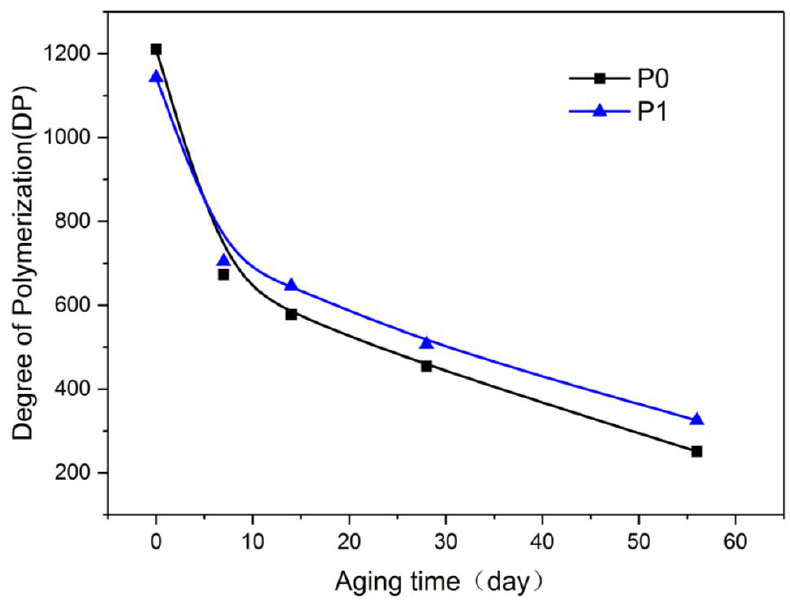
Figure 3. Variation of degree of polymerization (DP) with aging process.